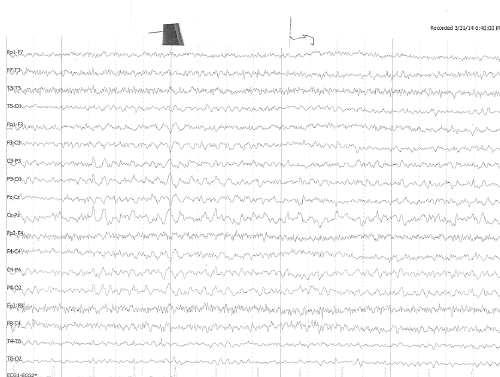
Figure1:Thepatient’selectroencephalogramhadnoabnormalfind-